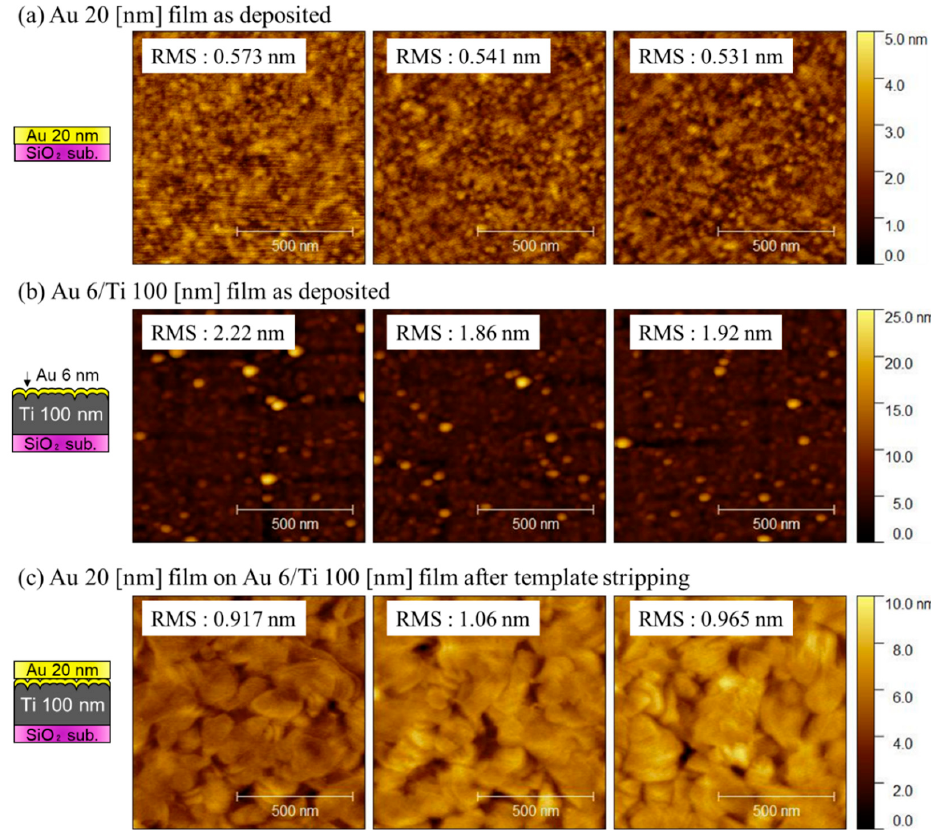
Figure 4. AFM images of the ( a ) thin Au layer on the SiO 2 template, ( b ) thick Au/Ti getter, and ( c ) Au/Ti getter layer smoothened by the TS process.